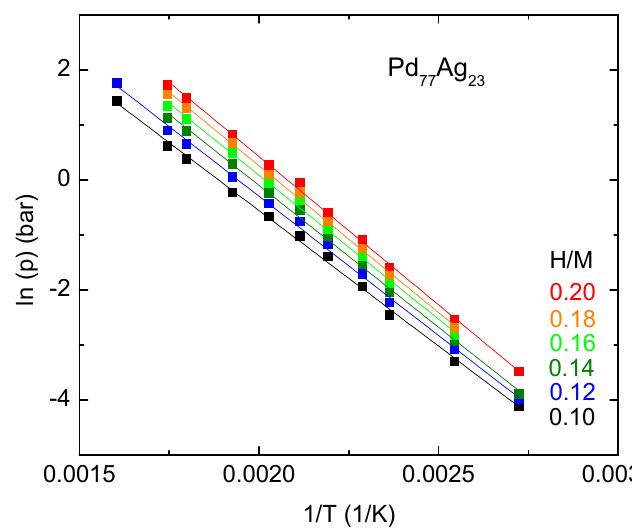
Figure 5. Van’t Hoff plot for Pd 77 Ag 23 at a fixed H/M in the higher concentration region and best fit lines to calculate the hydrogenation enthalpy.